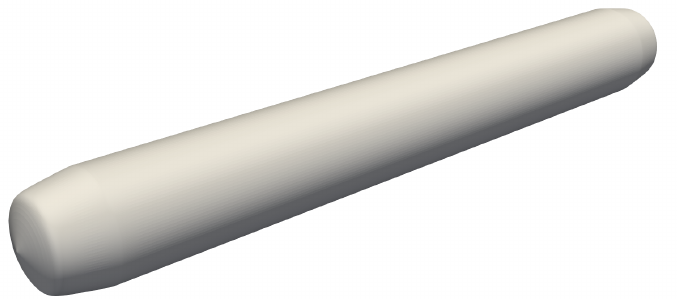
Figure 2. Geometry 1: Smooth cylindrical hull, representing a simplified geometry of the pres- sure hull.